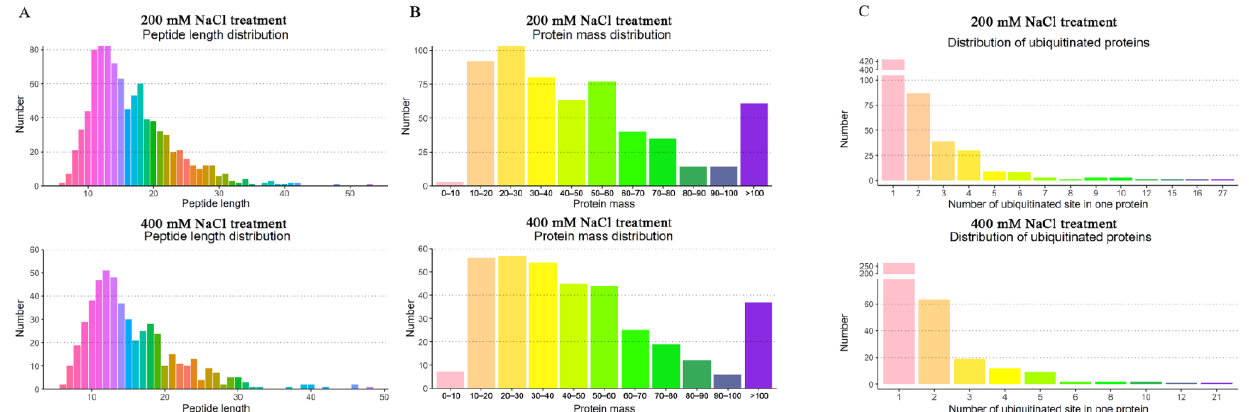
Figure 2. Distribution characterization of the identified ubiquitinated proteins. ( A ) Length distribution of the identified peptides derived from proteins in the roots of the sugar beet M14 line. ( B ) Mass distribution of the identified proteins in the sugar beet M14 line. ( C ) Distribution of the ubiquitination sites in the identified peptides derived from proteins in the sugar beet M14 roots. Top panel , 200 mM NaCl treatment; Bottom panel , 400 mM NaCl treatment.